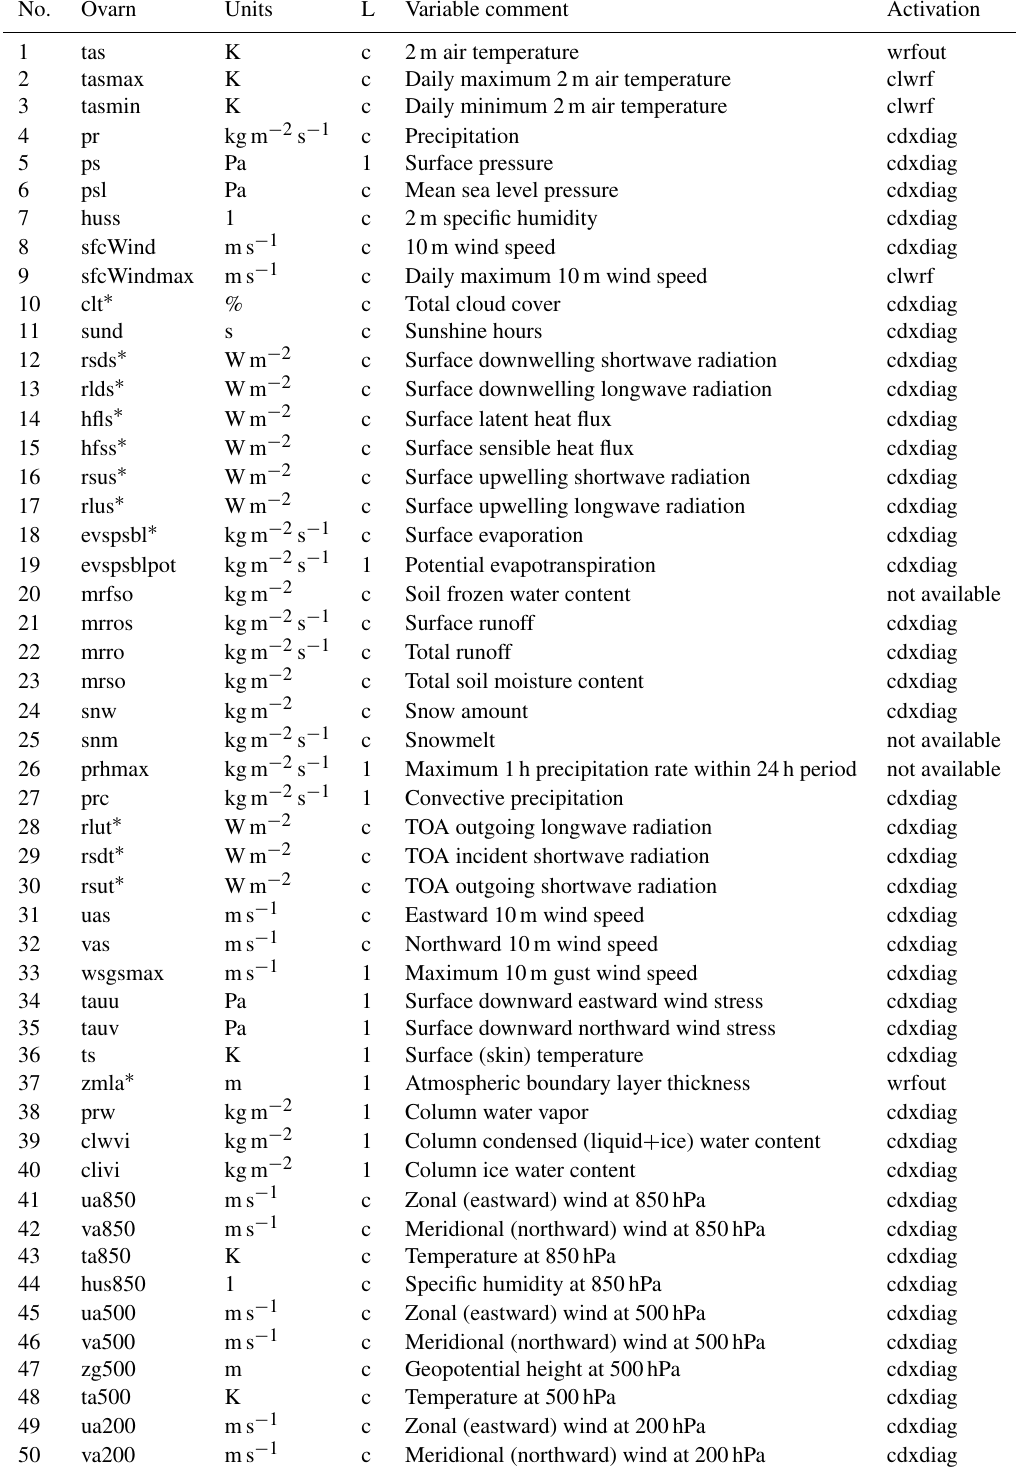
Table A1. CORDEX requested variables (from https://www.earthsystemcog.org/doc/detail/1065/). Ovarn: variable output name, L: level of requirement (c, Core; 1, Tier 1; 2, Tier 2), activation: option to get the variable from WRF (wrfout, standard WRF output; clwrf, after clWRF modifications; cdxdiag, basic CORDEXDIAG compilation; cdxwrf1, CORDEXDIAG activating pre-compilation flag cdxwrf=1; cdxwrf2, CORDEXDIAG activating pre-compilation flag cdxwrf=2; not available, not retrievable in this version of the module), ∗ indicates when a variable has a dependency on the chosen